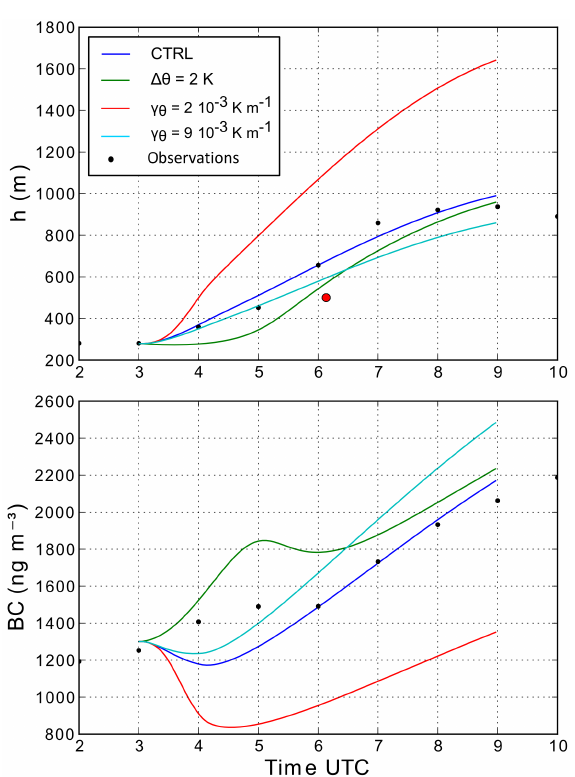
Figure 10. Sensitivity simulations of MXL simulated black car- bon variations with different boundary layer dynamics. The blue line shows the control experiment (CTRL), the green line a simula- tion with the initial potential temperature jump ( (cid:49)θ 0 ) set to 2K, the red line a simulation with a free tropospheric potential temperature lapse rate ( γ θ ) set to 0.002Km − 1 and the turquoise line a simula- tion with γ θ set to 0.009Km − 1 . In each panel, the black dots show observations made at the surface. In the top panel, the red dot shows the boundary layer height from a radiosonde